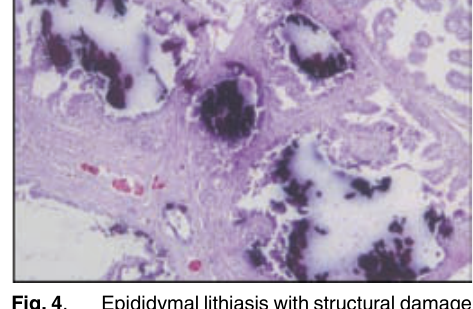
Fig. 4 . Epididymal lithiasis with structural damage in dilated efferent ductules (H&E x 400)